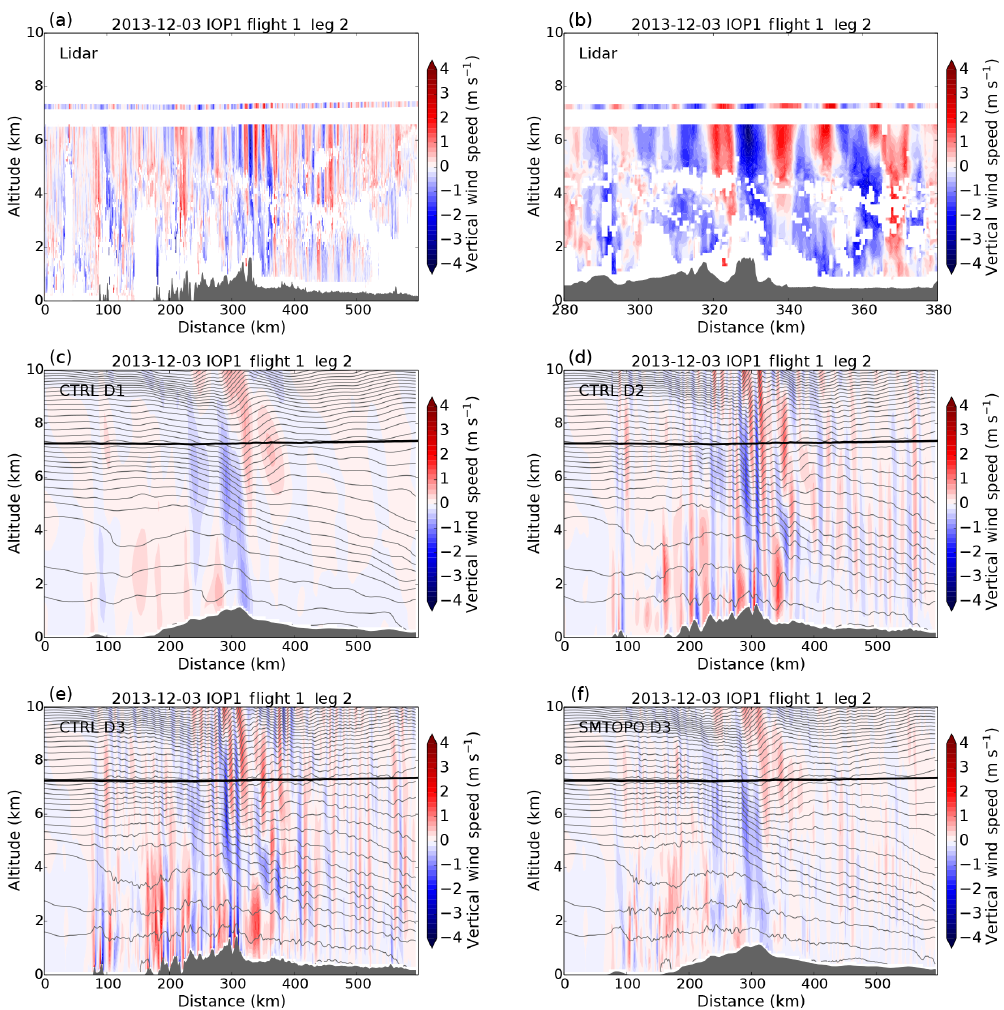
Figure 10. Cross sections for vertical velocity of flight 1, leg 2, during IOP1. Lidar and in situ measurements (data at 7.3km) are shown in panel (a) for the complete flight leg and in panel (b) for a smaller region over the mountains to enlarge the wave structures. Model results for vertical wind and potential temperature (contour interval 2K) of the CTRL D1, CTRL D2, CTRL D3 and SMTOPO D3 simulations are shown in panels (c) to (f) . The thick black line in panels (c) to (f) marks the flight altitude.